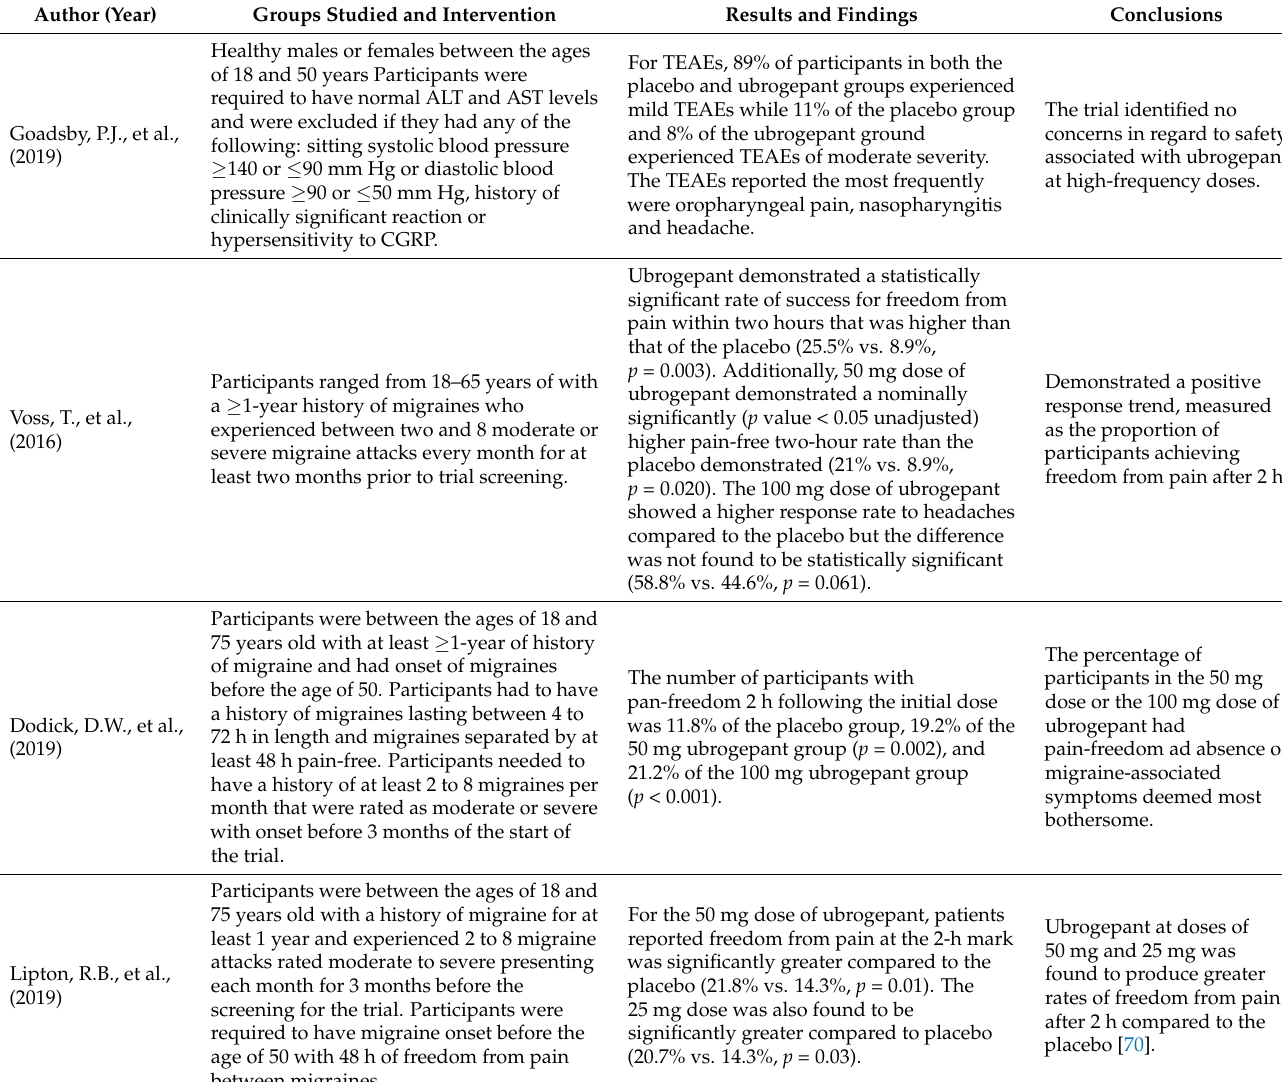
Table 2. Clinical Efficacy and